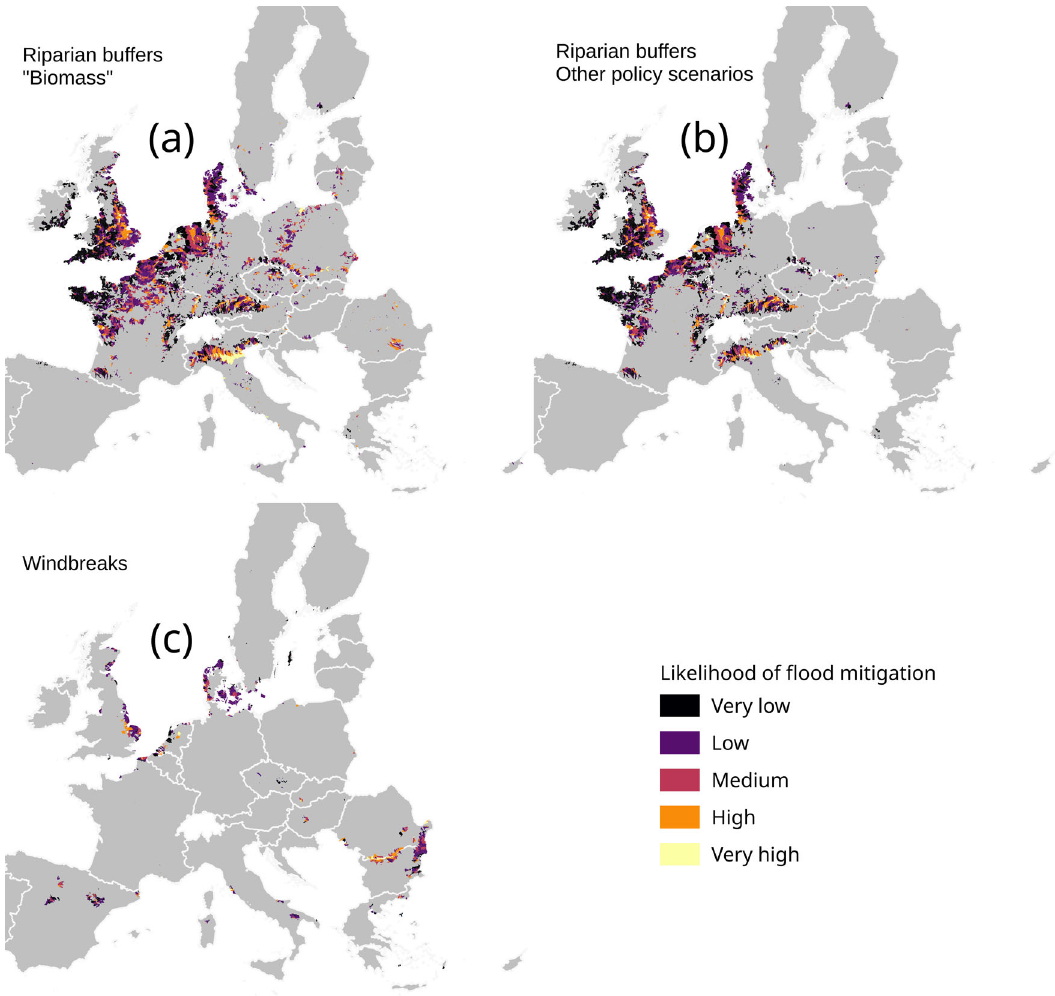
Fig. 8 Flood mitigation by implementation of riparian buffers and windbreaks. Likelihood of mitigated fl ooding events due to implementation of riparian buffers ( a , b ) and windbreaks ( c